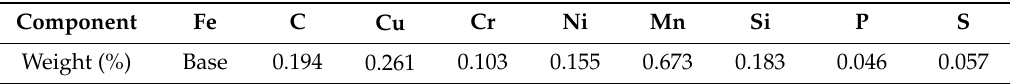
Table 2. Chemical composition of a mild steel